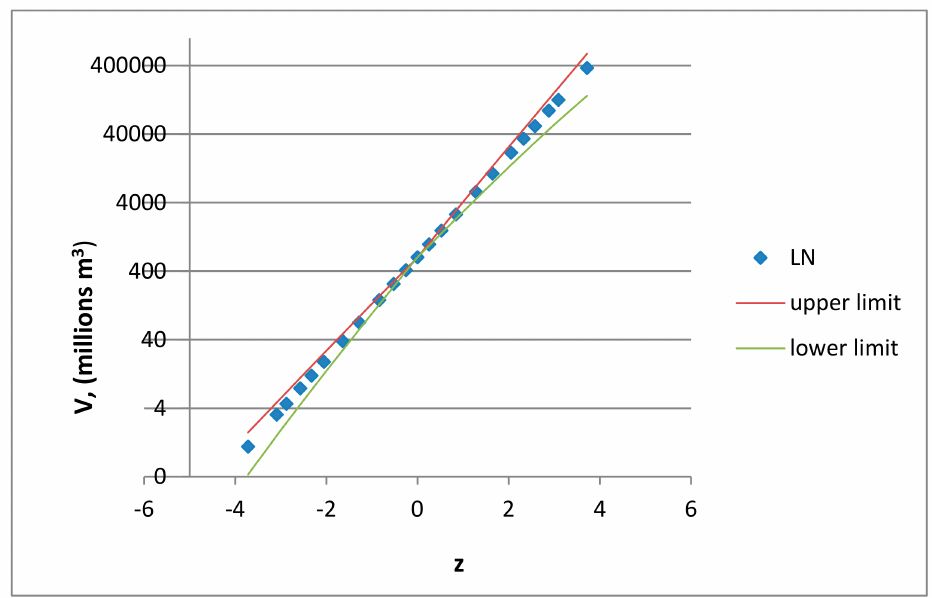
Figure 5. Confidence intervals of 95% for flood volumes of the Danube River at Smederevo station.